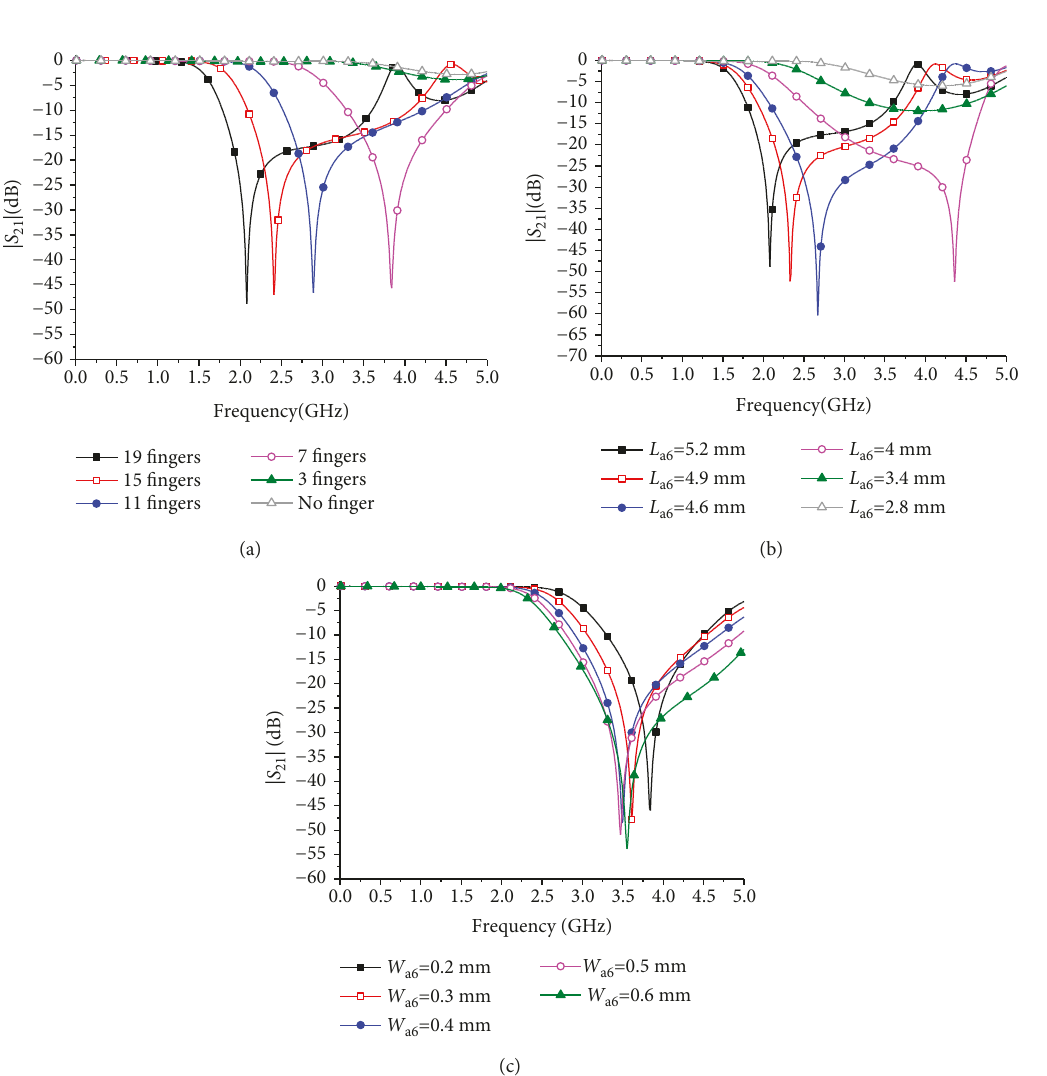
Figure 5: Harmonic suppression of the 70.7 Ω ATL: (a) di ff erent number, (b) di ff erent length, and (c) di ff erent